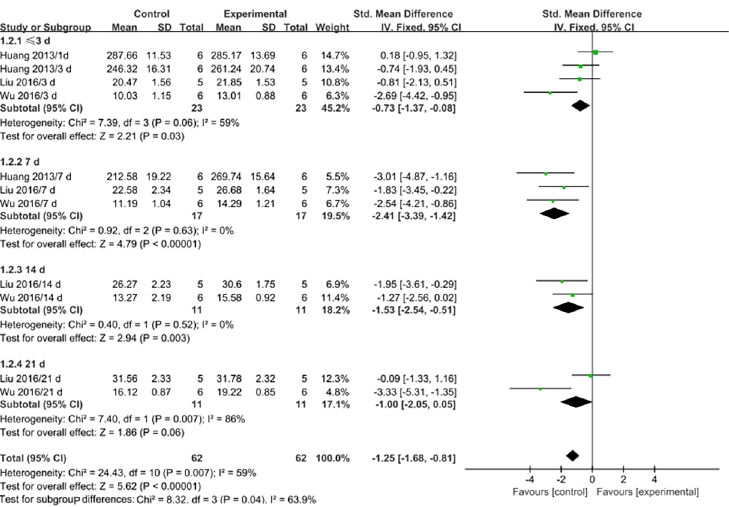
Fig 3. Forest plots showing the effects of MSCs on SOD levels. Control: PQ group; Experimental: MSC treatment group; CI: confidence interval; IV: independent variable; SD: standard deviation.